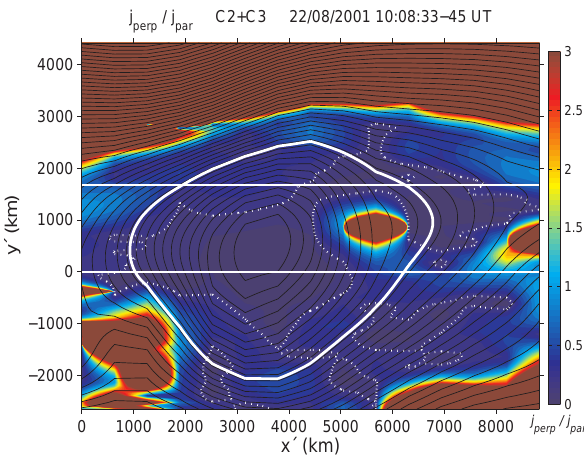
Fig. 4. The ratio of the perpendicular to the parallel currents % =| J ⊥ | / | J k | (color coded), showing the force-free core of the flux rope where r ≈ 0. The dotted white contour indicates the level where % = 0 . 3. Solid black contours are field lines in the ˆ x 0 – ˆ y 0 plane. The solid white contour corresponds to the boundary A b , and white hor- izontal lines are trajectories (upper C3, lower